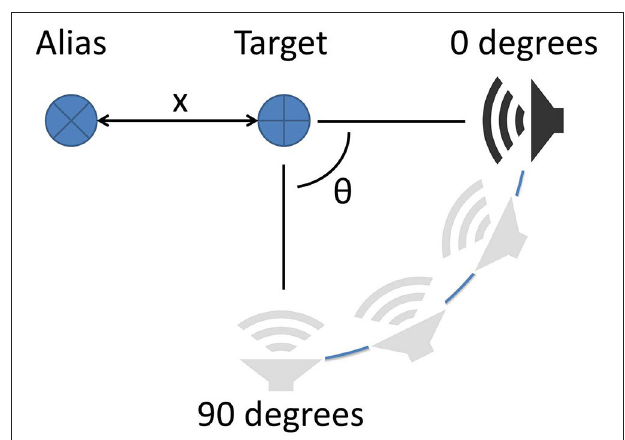
FIGURE 9 | Alias rejection via movement. The sonar system (speaker) is kept a constant distance from the target. The alias is located at a distance x from the target. The sonar is rotated around the target by angle θ to shift the view of the system.